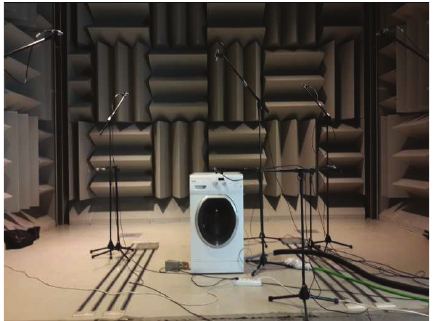
Figure 6: Washing machine in anechoic